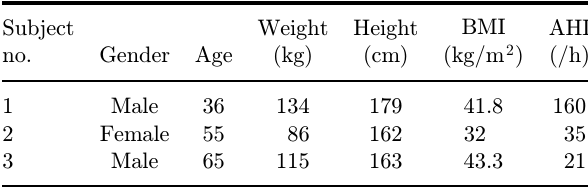
Table 1. Information of the three patients with